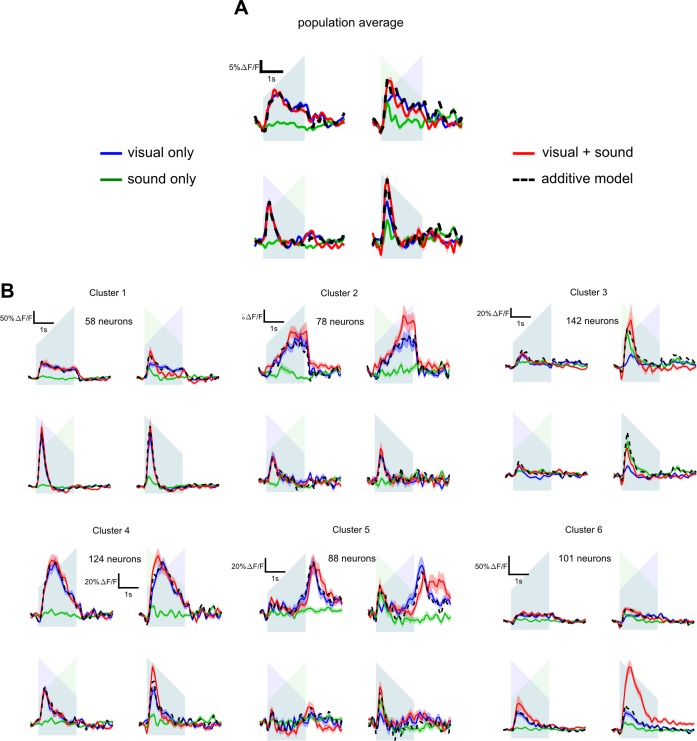
Bimodal responses in the area anteromedial to V1.(A) Population responses (3076 neurons, nine sessions, four mice) to the four unimodal stimuli and four bimodal stimuli in the area anteromedial to V1 (see Figure 3D). Down-ramping sounds alone elicit strong onset responses which at the population level sum linearly with visual responses. (B) Result of the clustering of uni- and multimodal responses in the anteromedial area. Six clusters were identified, five of which integrate mostly linearly auditory and visual responses and only one (bottom right) shows non-linear auditory-visual responses. Interestingly also, one cluster shows auditory responses that are stronger than visual responses (top right), corroborating the idea that auditory input to the associative region anteromedial to V1 has also a driving role and not only a modulatory role as we observe in V1.